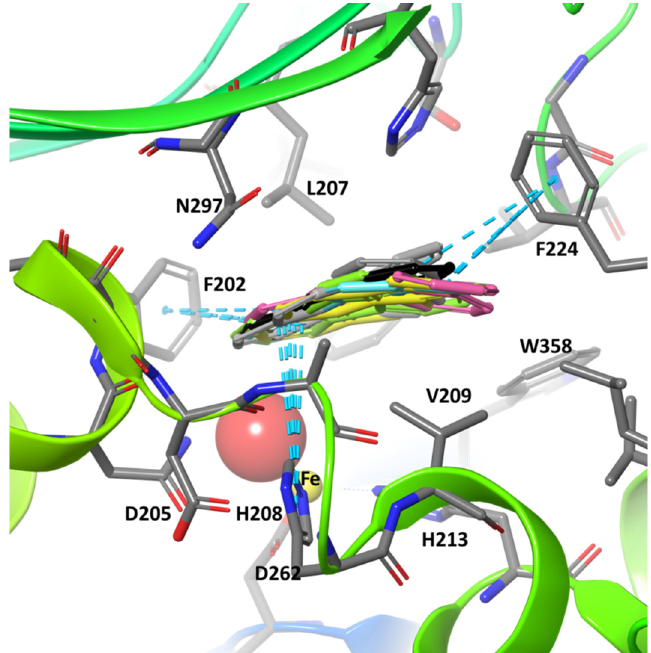
Figure 6. Model of naphthalene (orange), anthracene (pink), fluoranthene (green), pyrene (gray), chrysene (cyan), benzo(a)pyrene (yellow), and indeno(1,2,3-cd)pyrene (salmon) docked into binding site of naphthalene dioxygenase from Pseudomonas sp. C18 (ID 4hjl), with docking scores of − 6.1, − 7.6, − 8.1, − 8.1, − 8.9, − 9.9, and 9.0 (purpura) kcal/mol, respectively. Remaining binding site residues not shown to clarify the picture.